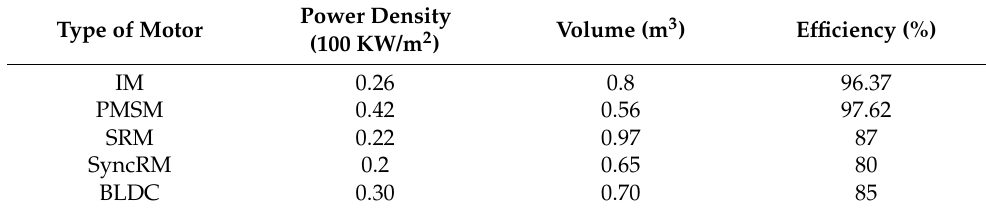
Table 4. Performance comparison of various types of motor.